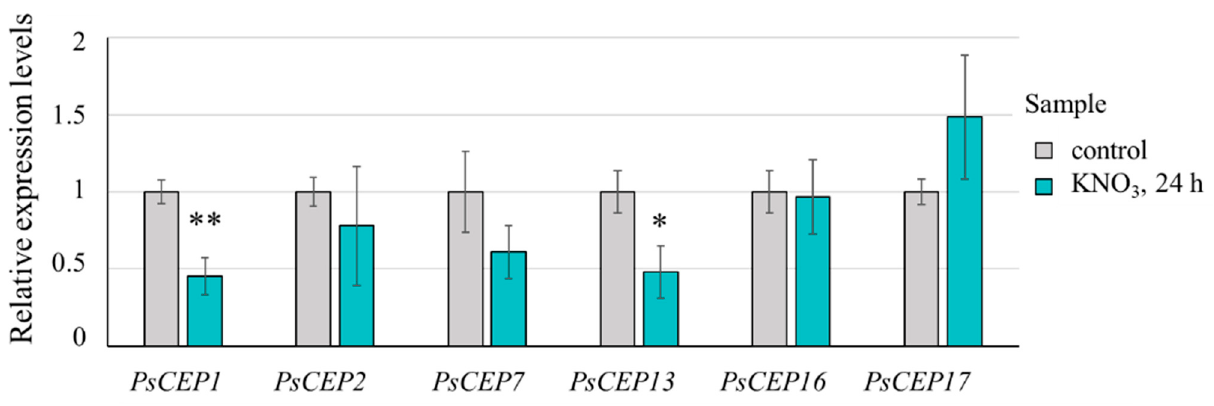
Figure 13. Expression levels of PsCEP genes in response to nitrate (10 mM KNO 3 , 24 h). Results are means ± SEM of 4–5 biological samples; Asterisks indicate statistically significant differences compared with the control (** p < 0.01; * p < 0.05) revealed by a Student’s t test. The gene expression levels were normalized to 1 against the expression level found in the control roots.